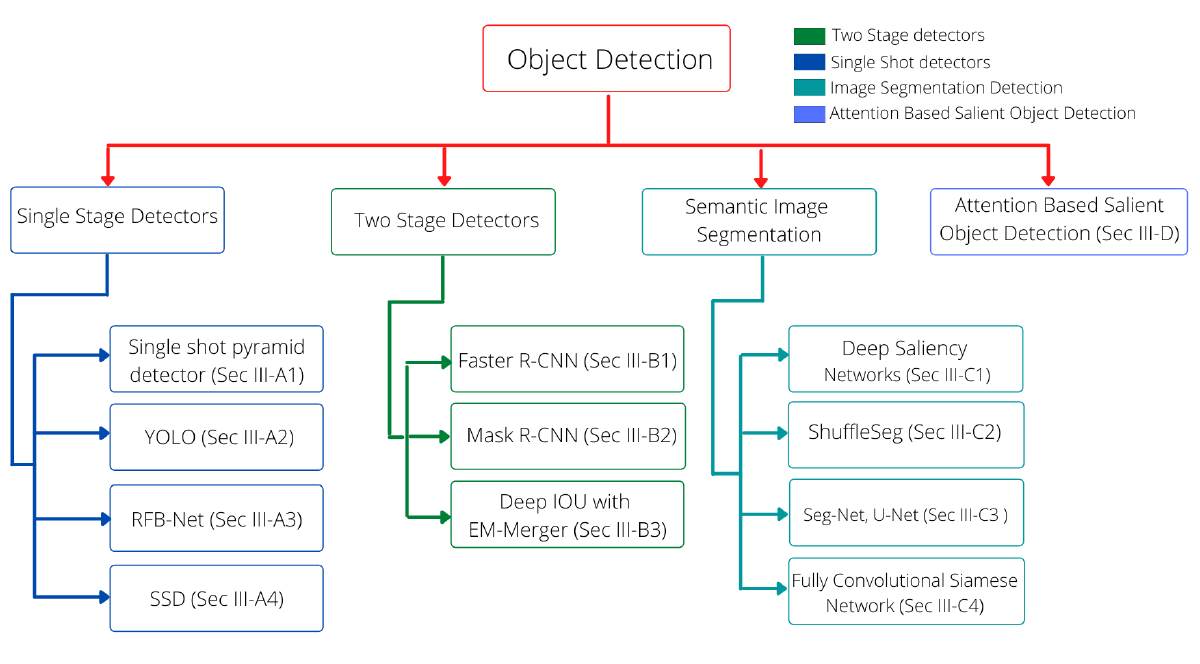
Figure 5. Organization of explained methodologies in this paper. The problem of object detection in challenging environ- ments has been tackled by employing various deep learning concepts. In this paper, we categorize these methods according to the utilized